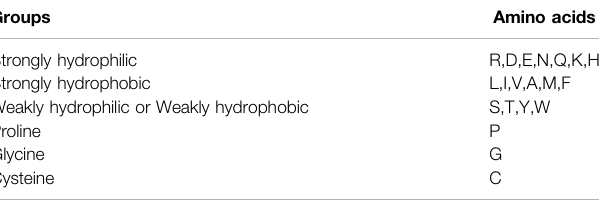
TABLE 1 | The six groups of the 20 amino acids.